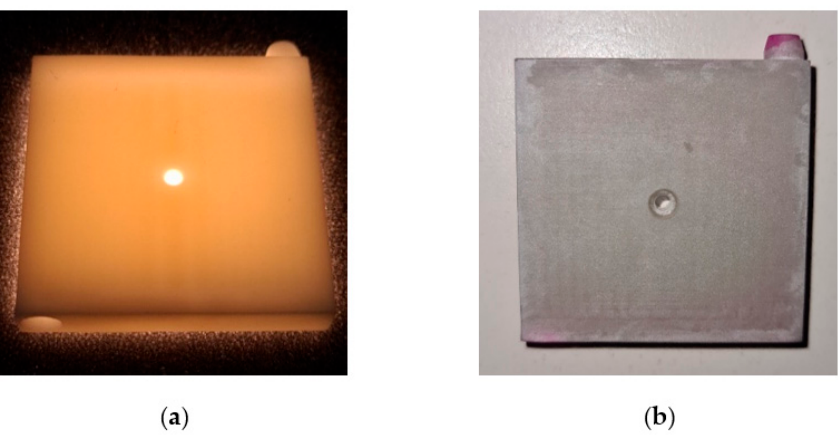
Figure 11. ( a ) Visual inspection of a complex substrate with inner cooling channels via lamp fluor-